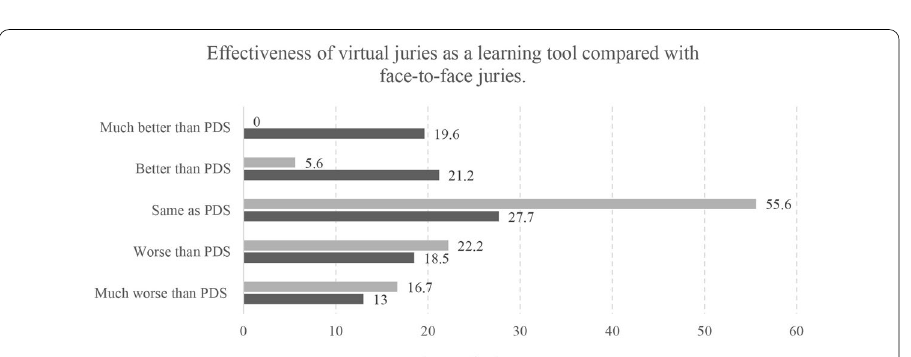
Fig. 6 Effectiveness of virtual juries compared with physical